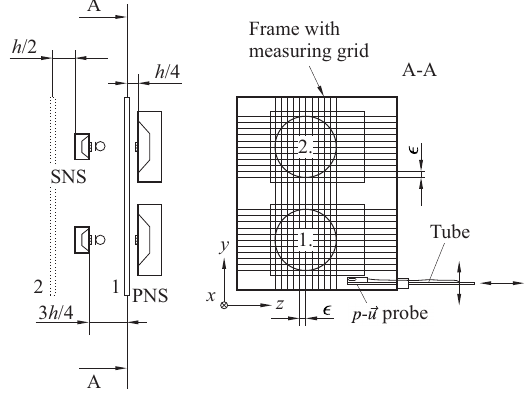
Figure 9: Measuring setup for sound intensity mapping.